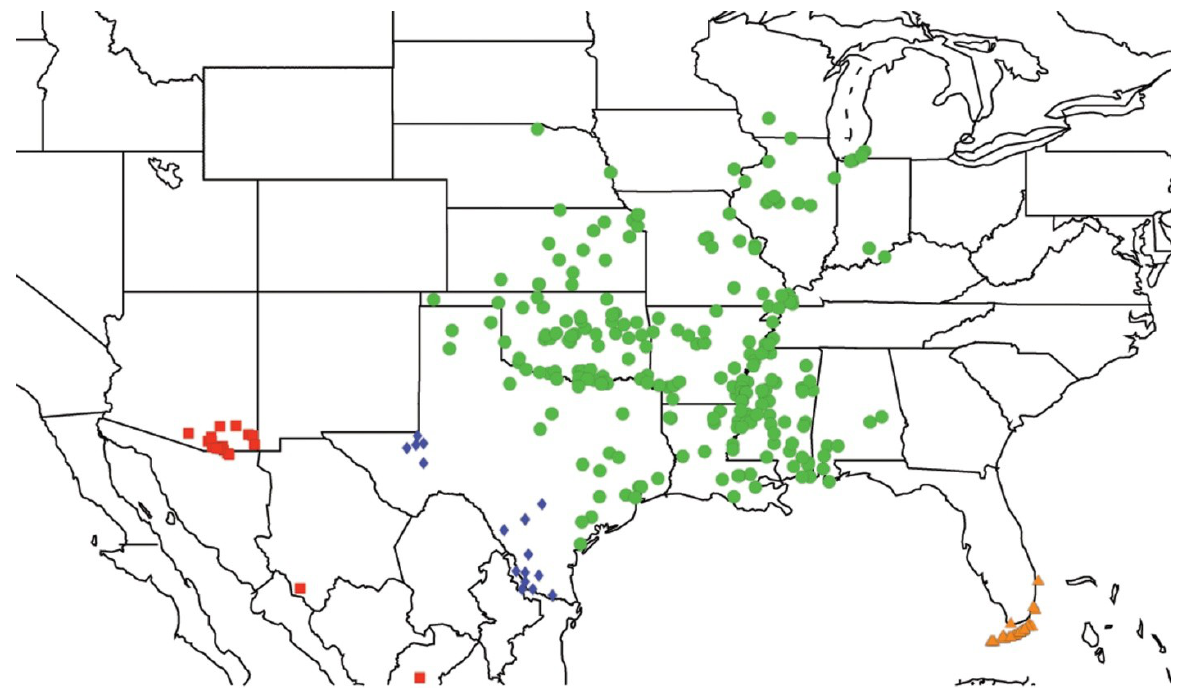
Figure 9. Distribution of Dicerprocta arizona (red squares), D. averyi (blue diamonds), D. vitripennis (green circles) and D. biconica (orange